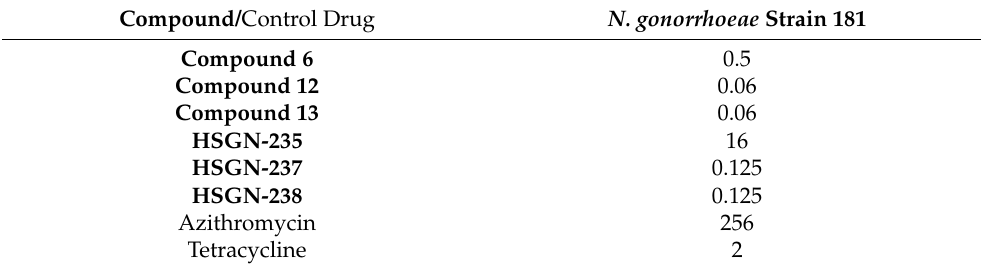
Table 1. MICs ( µ g/mL) of the previously reported analogs ( compounds 6 , 12, and 13 ) and the new compounds ( HSGN-235 , -237, and -238 ) against N. gonorrhoeae strain 181. The experiment was repeated 3 independent times and the same MIC values were obtained. Compounds tested are in bold while control drugs are in regular script.